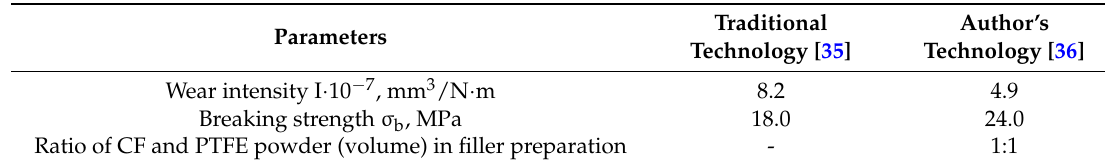
Table 8. Physical, mechanical and tribotechnical properties of CFRP obtained by traditional and author’s technologies.